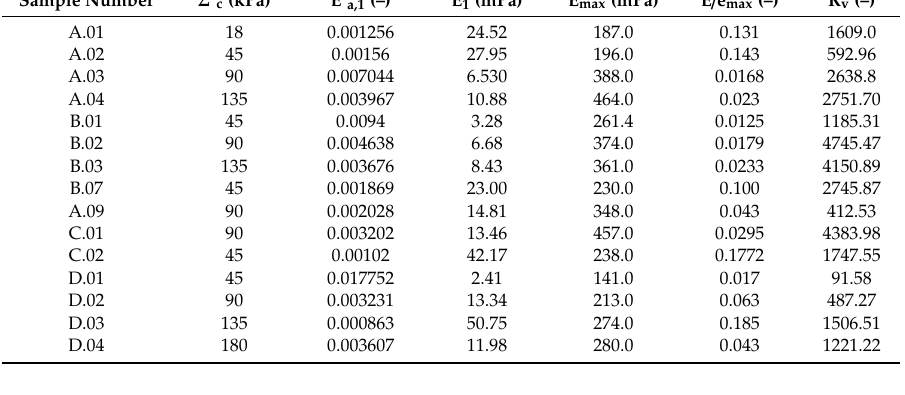
Table A1. Test data axial strain analysis.